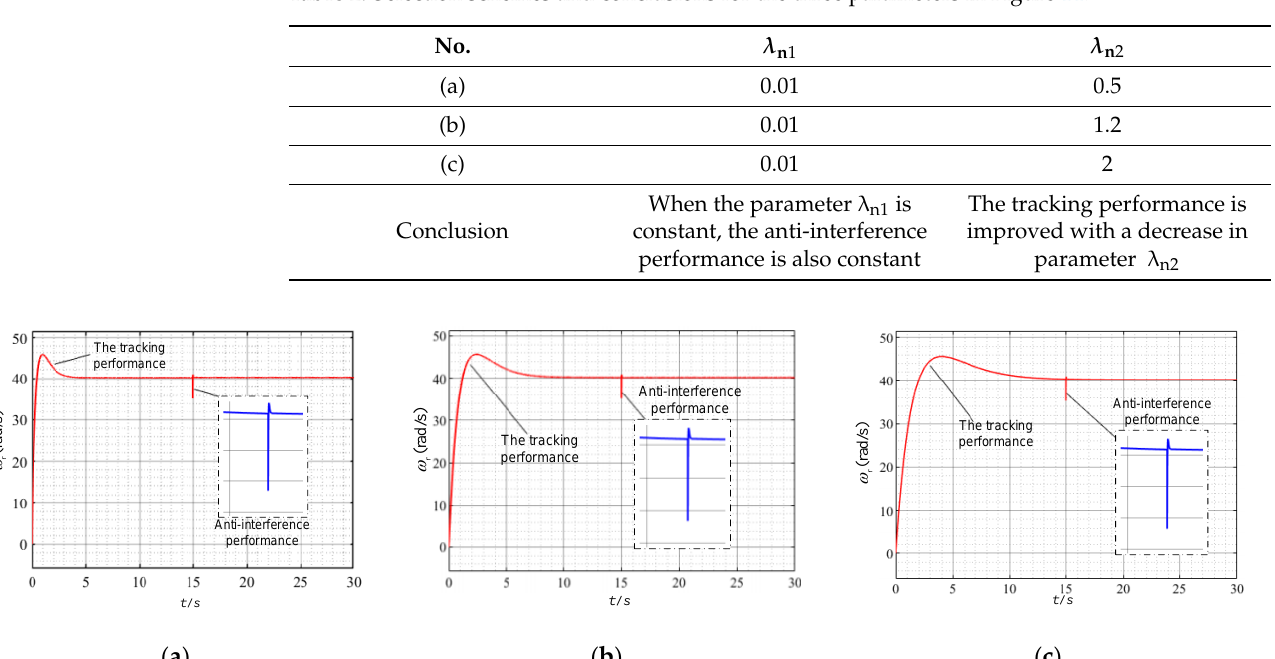
Table 2. Selection schemes and conclusions for the three parameters in Figure 14.